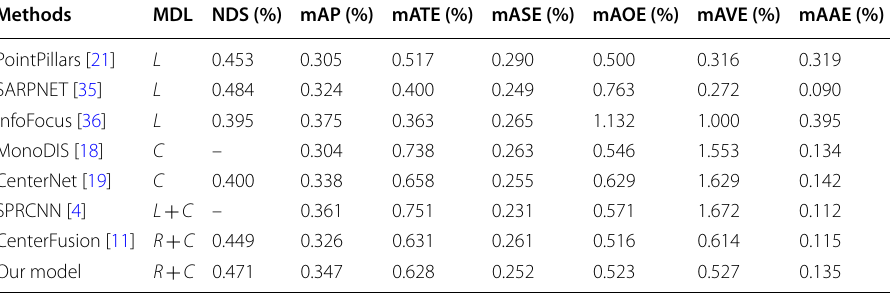
Table 1 Performance comparison results of 3D target detection models in the nuScenes test